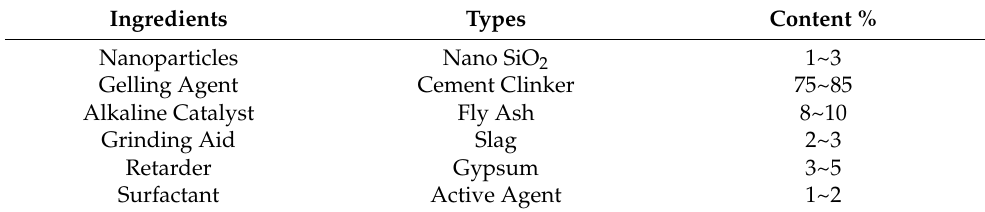
Table 1. Composition and content of N-MBER.